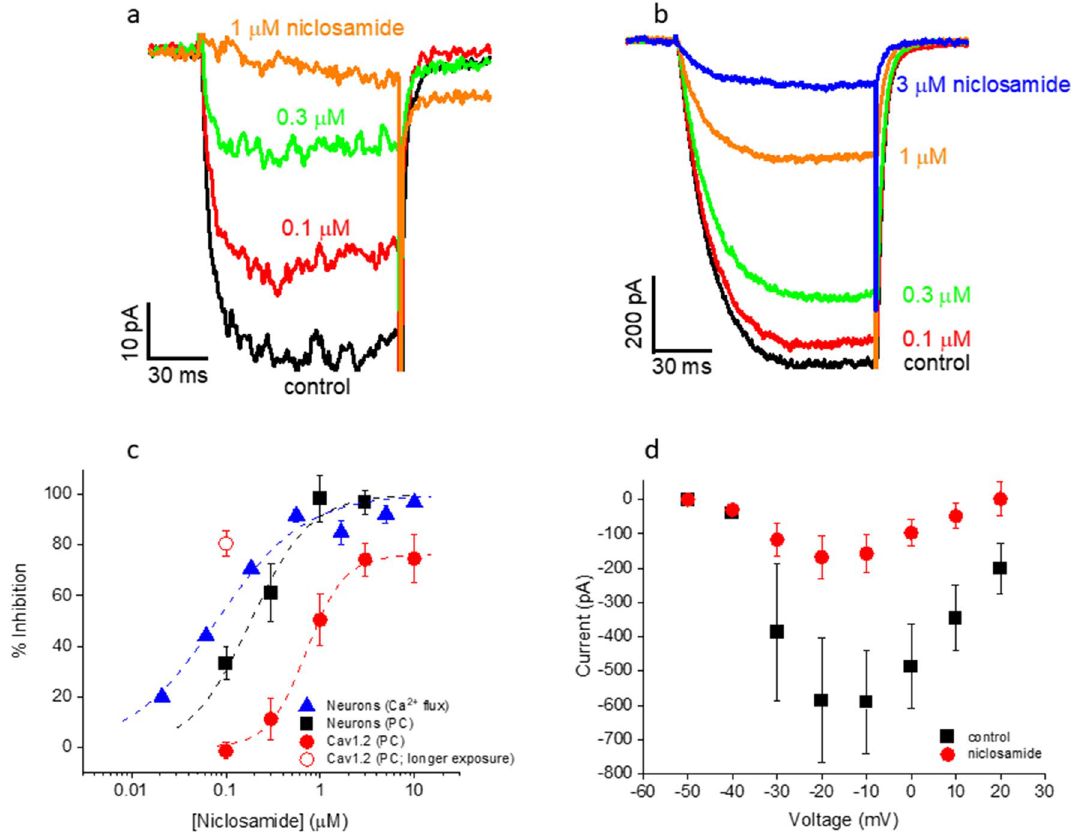
Figure 6. Effect of niclosamide on LTCC currents from rat cortical neurons and Ca V 1.2 currents in CHO cells . ( a ) Current traces from a neuron in the absence and presence of niclosamide. ( b ) Current traces from a Ca V 1.2- expressing CHO in the absence and presence of niclosamide. ( c ) Concentration-dependent inhibition of LTCC- mediated calcium flux in cortical cultures (solid triangles; IC 50 = 79.5 ± 12.8 nM; maximal % inhibition = 100%; n = 3), LTCC currents recorded from cortical neurons (solid squares; IC 50 = 183.1 ± 28.2 nM; maximal % inhibition = 100%; n = 6) and Ca V 1.2-expressing CHO cells (solid circles; IC 50 = 715.3 ± 49.2 nM; maximal % inhibition = 76.1 ± 2.0%; n = 7; p < 0.001 vs neurons, two-way ANOVA). At 100 nM niclosamide, inhibition of Ca V 1.2 was significantly greater when CHO cells were exposed to the compound for longer periods (open circle, 80.6 ± 4.9%, n = 4) than that of LTCCs in neurons (solid squares; p < 0.001, one-way ANOVA) or that of Ca V 1.2 when CHO cells were exposed to the compound for shorter periods (solid circles; p < 0.001, one-way ANOVA). All patch clamp experiments were performed in the presence of 300 nM Bay K8644 at a holding potential of -50 mV and test potential of − 20 mV. ( d ) I-V plots in the absence (squares) and presence (circles) of 200 nM niclosamide (from the same 5 neurons). The holding potential was − 50 mV. A cocktail of VGCC blockers, SNX-482 (30 nM), ɷ -agatoxin IVA (200 nM), ɷ -conotoxin GVIA (1 µM) and ɷ -conotoxin MVIIC (1 µM), was present in the extracellular